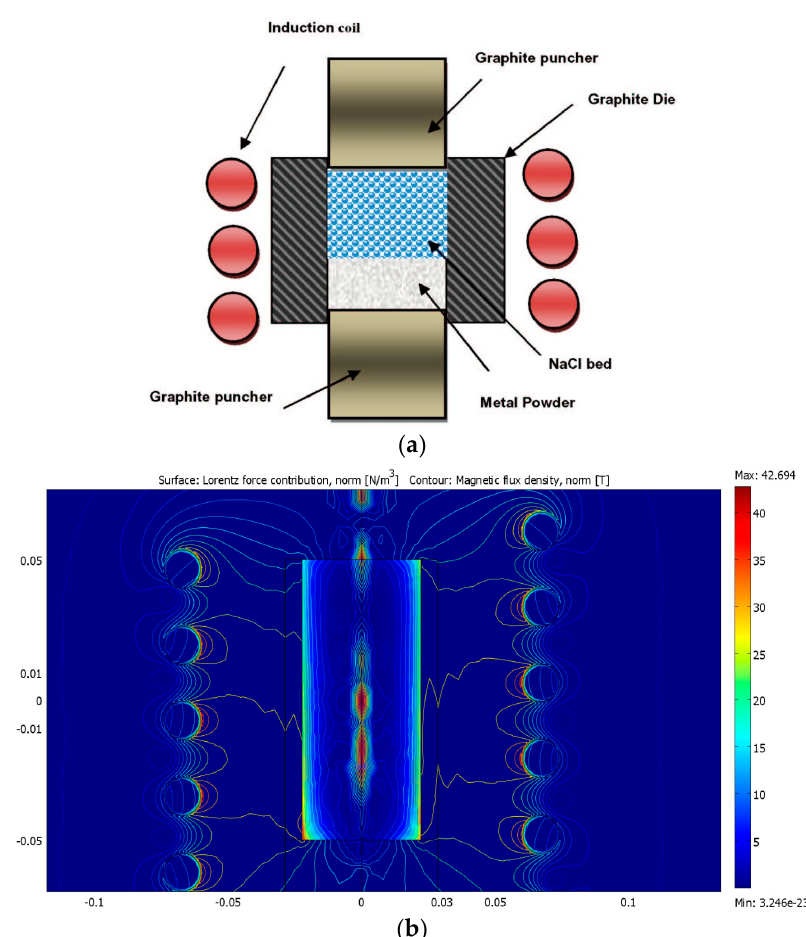
Figure 2. Schematic sketches of ( a ) the graphite die assembly placed in the center of an induction coil, and ( b ) distribution profiles of the magnetic field and Lorentz force throughout the graphite die (using Maxwell’s equations).